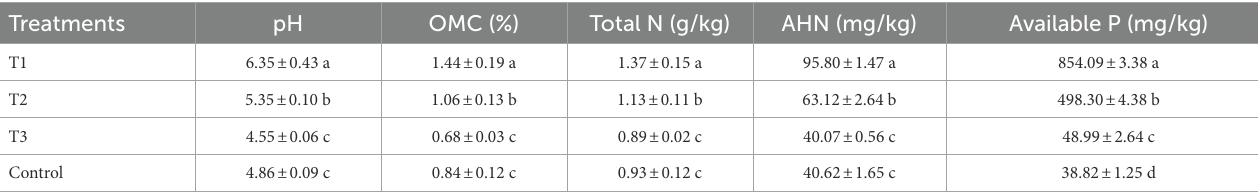
TABLE 3 Effects of MF-HZ23 on the pH and chemical properties on pakchoi soil. Treatments